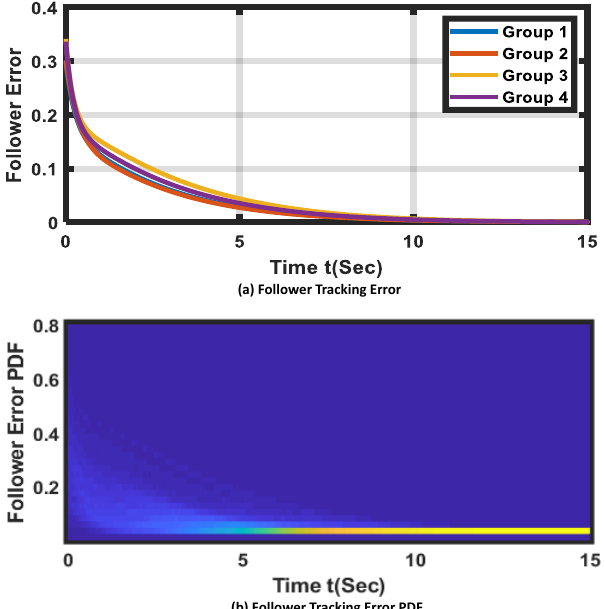
Figure 5. The tracking errors and the tracking error PDF of the